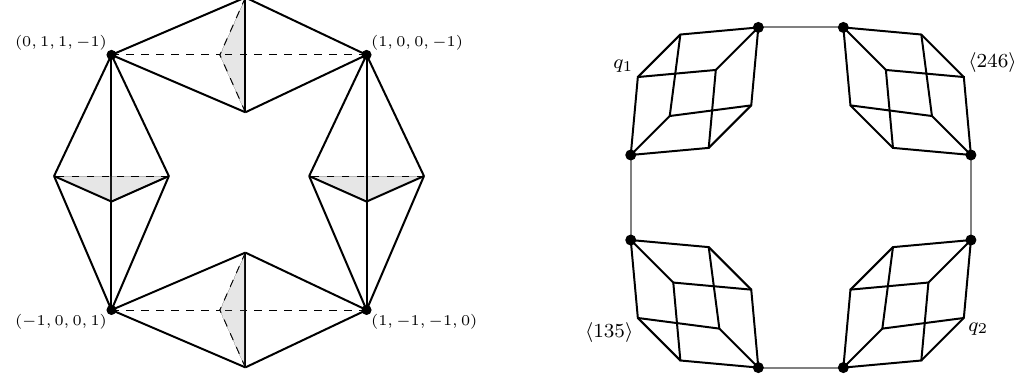
Figure 3. Left: a subset of the cluster fan (or more precisely its intersection with the unit sphere) showing eight tetrahedral facets and four highlighted triangles. The highlighted vertices correspond to the four rays given. Right: the subgraph of the D 4 cluster polytope formed by keeping only the clusters whose active nodes are connected in the shape of a D 4 Dynkin diagram. The cubes correspond to the A -coordinates shown and are dual to the four highlighted vertices of the left figure. The grey edges connecting the four cubes are dual to the highlighted triangles of the left figure. The highlighted vertices (clusters) are dual to the eight tetrahedra of the left figure.